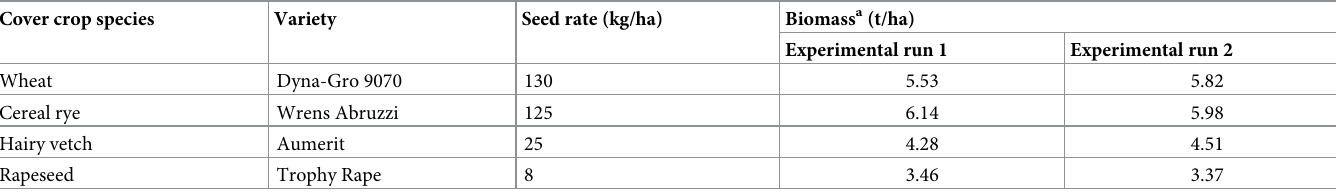
Table 1. Seeding rate, variety, and biomass of respective cover crop species at termination. Cover crop